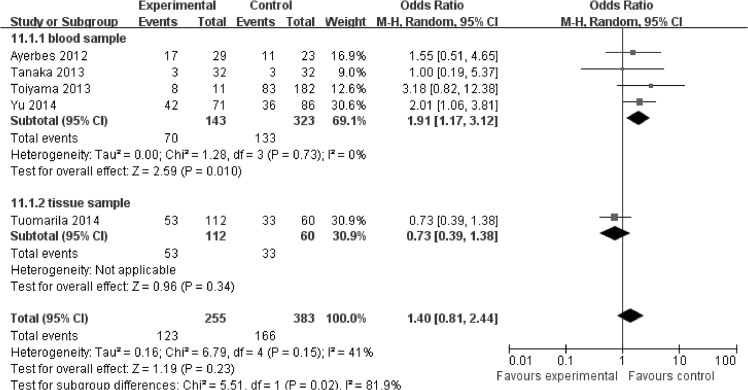
Meta-analysis evaluating miR-200c expression and distant metastasis in cancer patients.